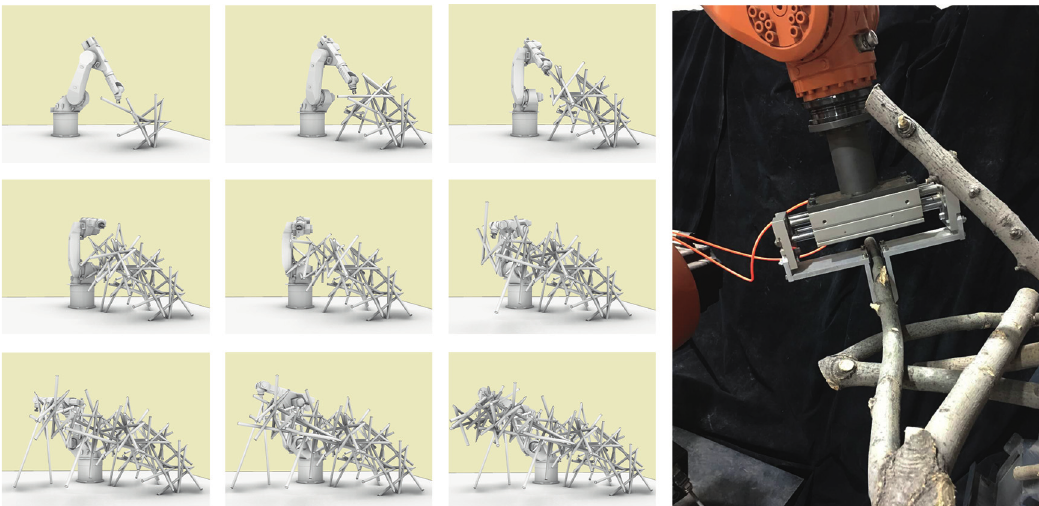
Figure 16: Robotic construction process.